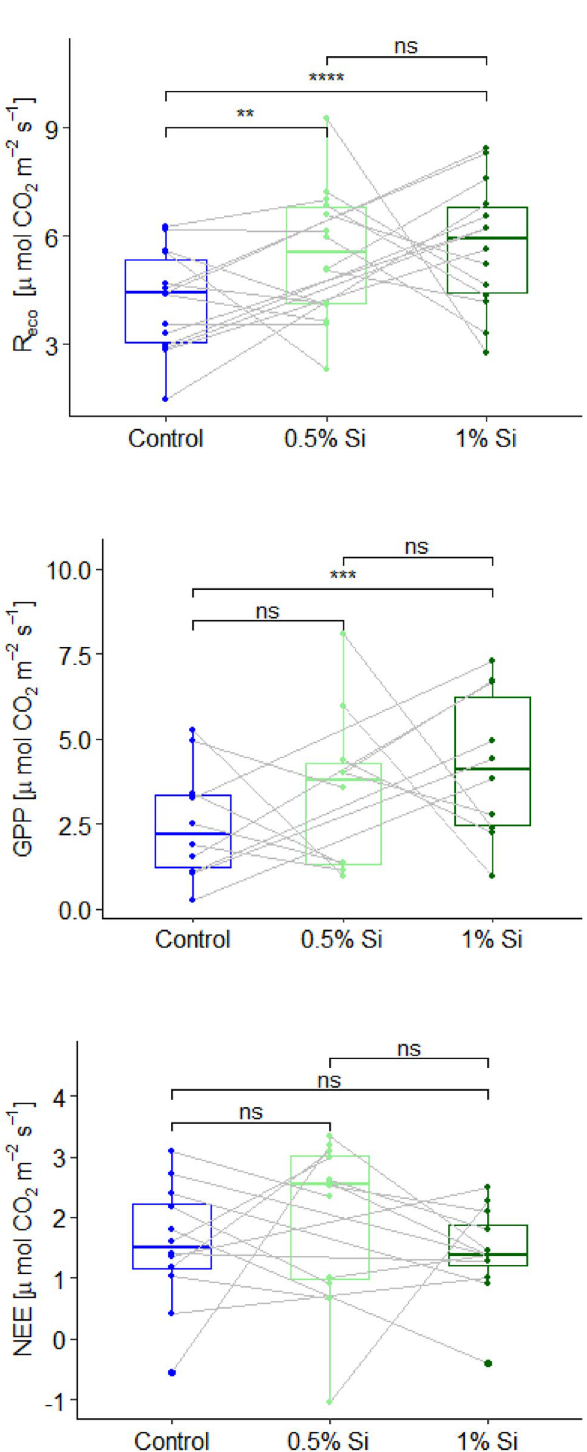
Figure 3. Closed chamber based R eco , GPP and NEE fluxes grouped for the different treatments (control, 0.5% ASi and 1% ASi) and pairwise compared (lines show data pairs of the different measurement